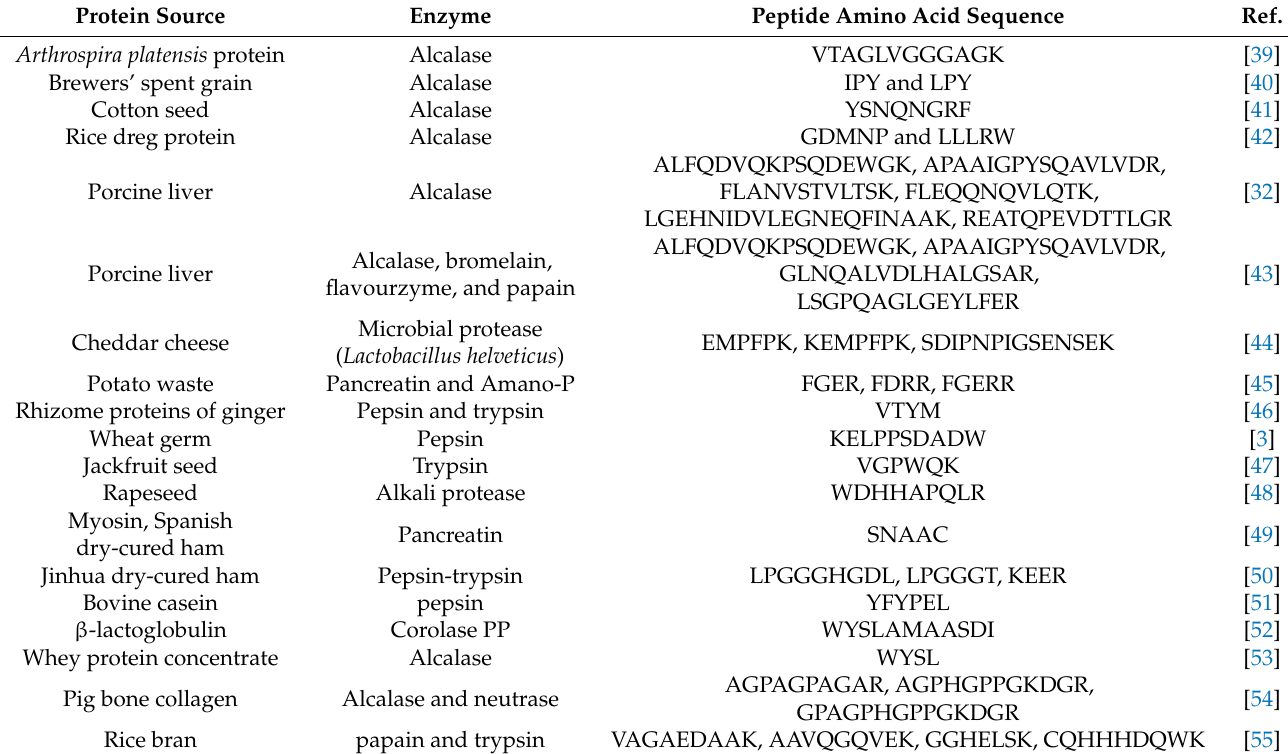
Table 1. Antioxidant activity of bioactive peptides obtained from different protein